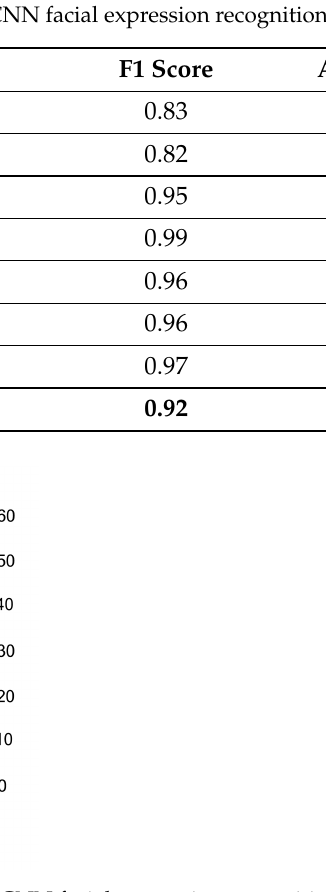
Figure 8. Confusion matrix of seven emotions with DCNN facial expression